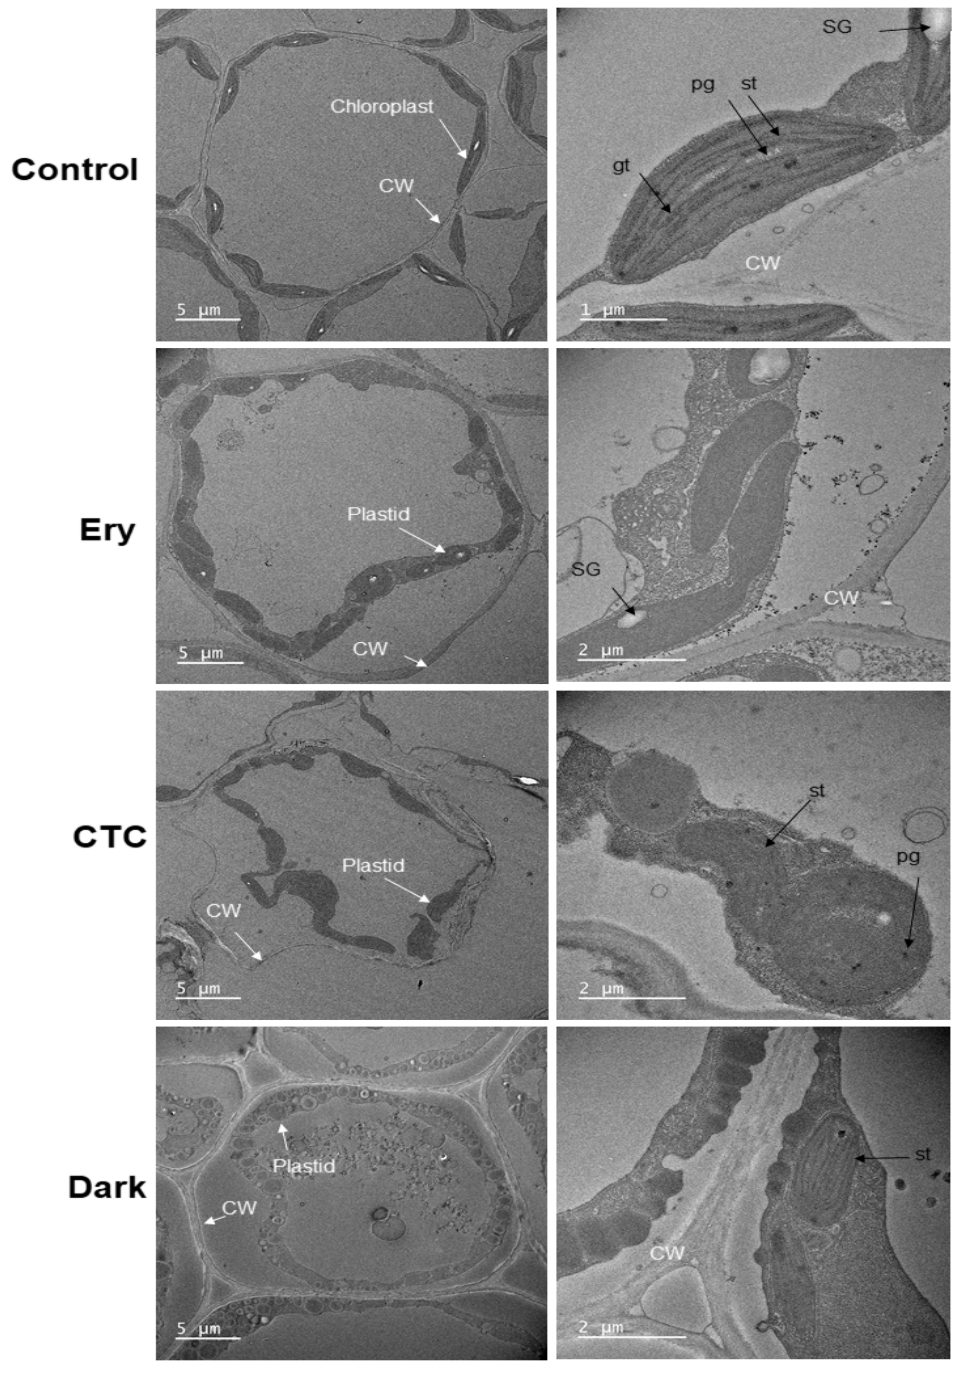
Figure 5. Ultrastructural changes in epidermal plastids. Transmission electron microscopy of